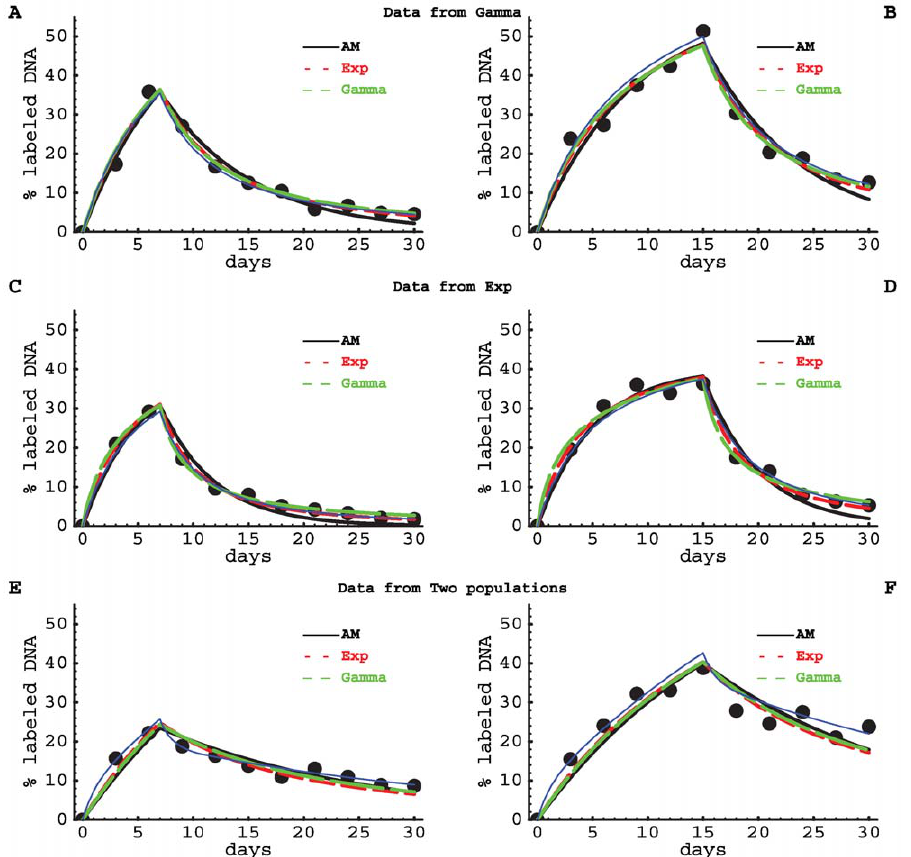
Figure 4. Fits of artificial (simulated) data with various models. We have fitted artificial data (black dots) with the Asymptote model (eqn. (1), solid black lines), the Exponential model, in which a fraction a of the cells have exponentially distributed turnover rates (eqn. (8), small red dashed lines), and the Gamma model with gamma distributed turnover rates (eqn. (4), large green dashed lines). Data were generated using the Gamma model (panel A&B), the Exponential model (panel C&D) and the Two-populations model (panel E&F, Eqn. (2)), respectively. Thin blue lines show the exact curves of the models that were used to generate the data. The different models were fitted to 11 datapoints taken from these predicted curves after having added noise to these data points. Noise was added by a relative change of the predicted value with a normally distributed error (with standard deviation of the distribution s ~ 0 : 1 ). The models were fitted to data from artificial labeling experiments in which the label was administered for 7 (left panels) or 15 (right panels) days. Parameter estimates providing the best fit are shown in Table S1, and the corresponding estimates of the average rates of cell turnover (cid:1) dd are shown in Figure 5. Parameters used to generate the data are also given in Table S1.